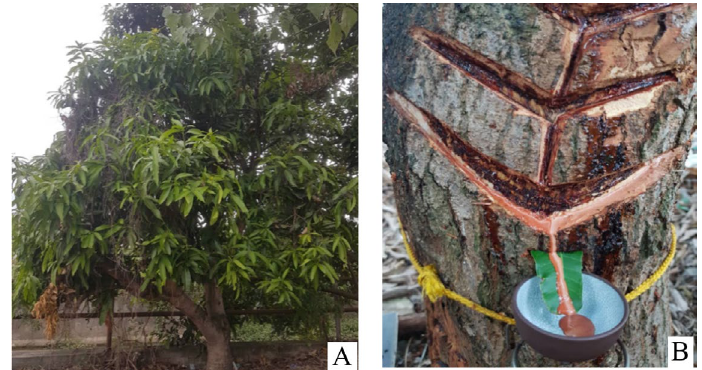
Fig. 1. Collection of plant gum from Mangifera indica tree; A- Plant, B- Gum collected in a silica